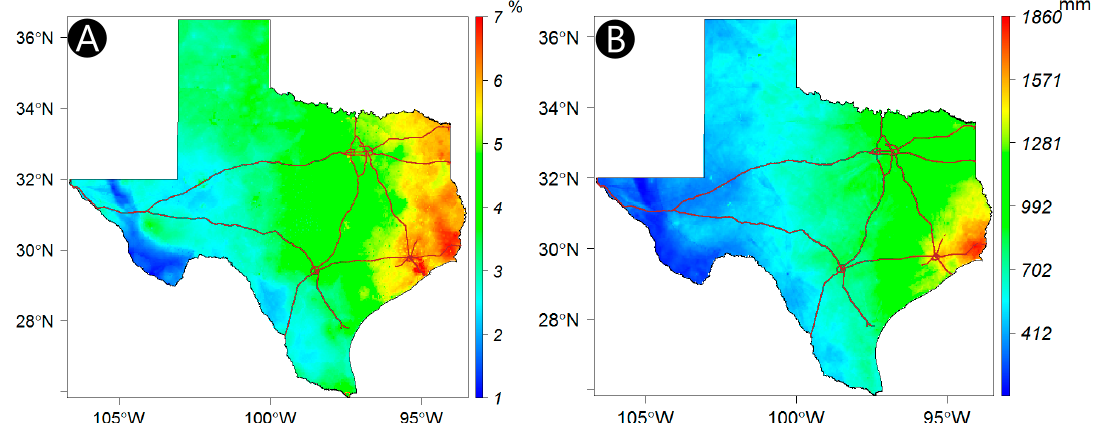
Figure 3. ( A ) Spatial distribution of the average annual frequency of hourly precipitation in the State of Texas and ( B ) the annual average cumulative precipitation.